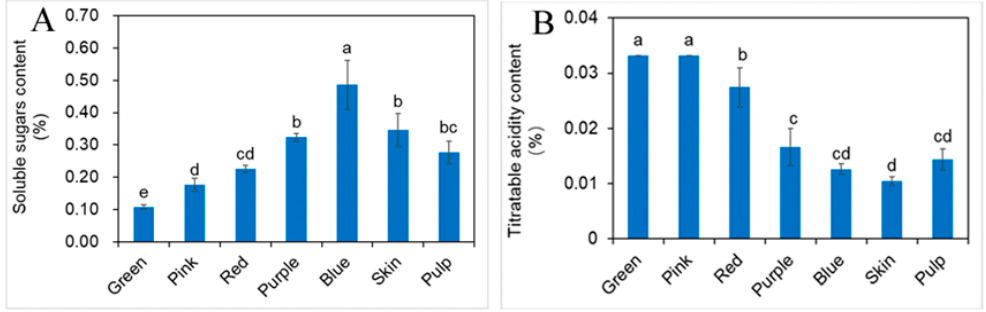
Figure 1. Changes of the contents of soluble sugar ( A ) and titratable acidity ( B ) for blueberry at different developmental stages of fruit, skin and pulp (mean ± SD, n = 3). Bars with different letters differ significantly ( p < 0.05).